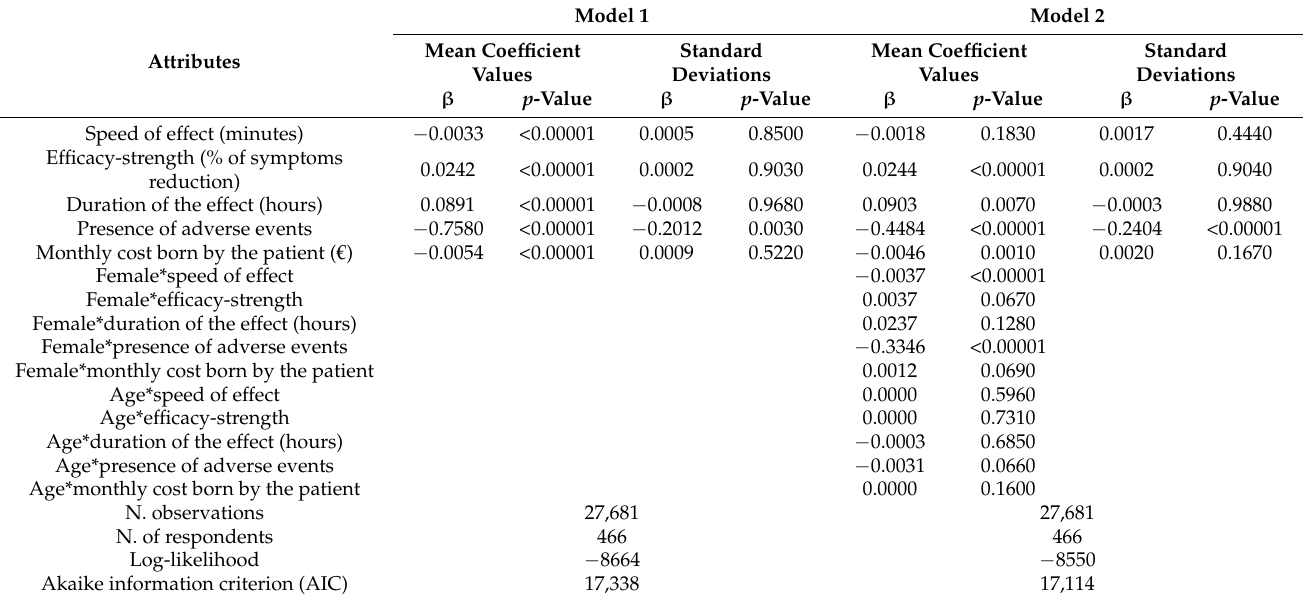
Table 3. Results of the mixed logit Models 1 and